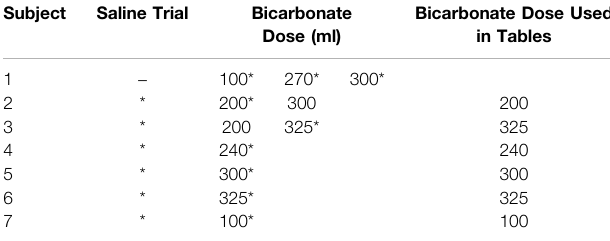
TABLE 1 | Bicarbonate dose and availability of blood